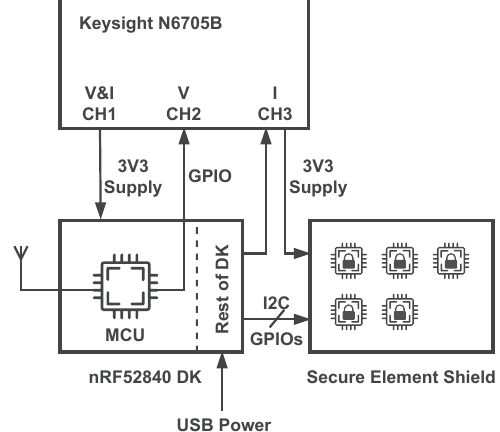
Figure A1. Measurement setup of the secure node for acquiring the execution time and energy consumption during the stated test cases.